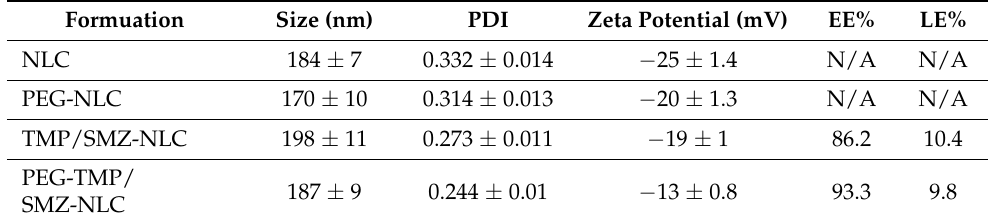
Table 2. Size, polydispersity index (PDI), zeta potential, EE%, and LE% of various nanoparticles obtained by Zetasizer and ultra-high performance liquid chromatography (UHPLC).